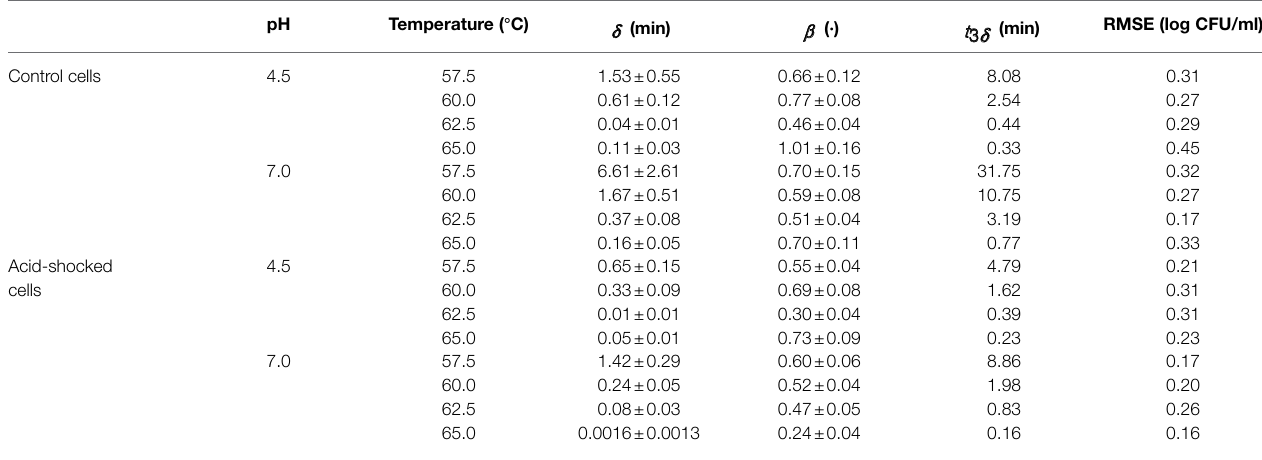
TABLE 1 | Parameters of the Weibull model estimated from the survival curves of S . Senftenberg heat treated in peptone water without a prior acid shock (control cells) and after an acid shock at pH